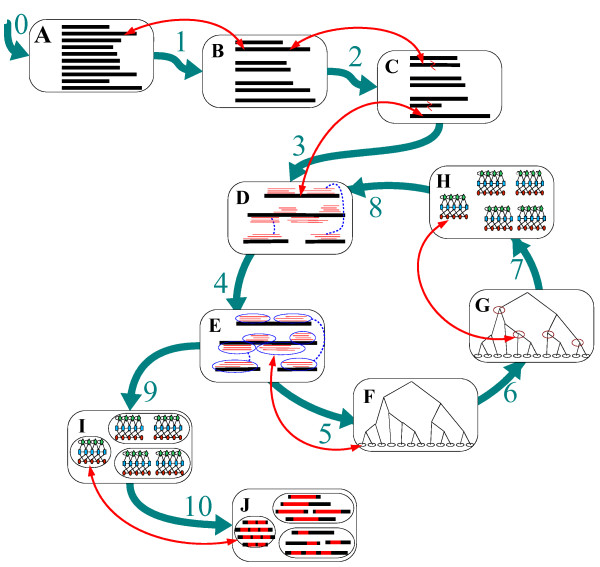
The EVEREST process. The turquoise arrows represent the steps of the procedure as detailed in the text. The panels represent the state of the data between the steps. Red arrows connect two manifestations of the same object. 0 Input: a database of protein sequences. 1 A non-redundant sequence database is created. 2 Internal repeats are removed from sequences. 3 Segments recurring in the database are identified using pairwise sequence comparison. 4 Within each protein, segments are grouped by position into putative domains. 5 Putative domains are clustered into candidate domain families. 6 Machine learning is used to select the best of the candidate domain families. 7 An HMM is built for each selected domain family. 8 The input database is scanned by each HMM, recreating a segments database. The segments defined by each HMM are considered a domain family. 9 Steps 4–8 are iterated three times. The domain families defined by the third iteration HMMs are clustered into sets of overlapping families. 10 Final domain families are defined by a voting of all the HMMs of each set. See section The EVEREST Process for further details.